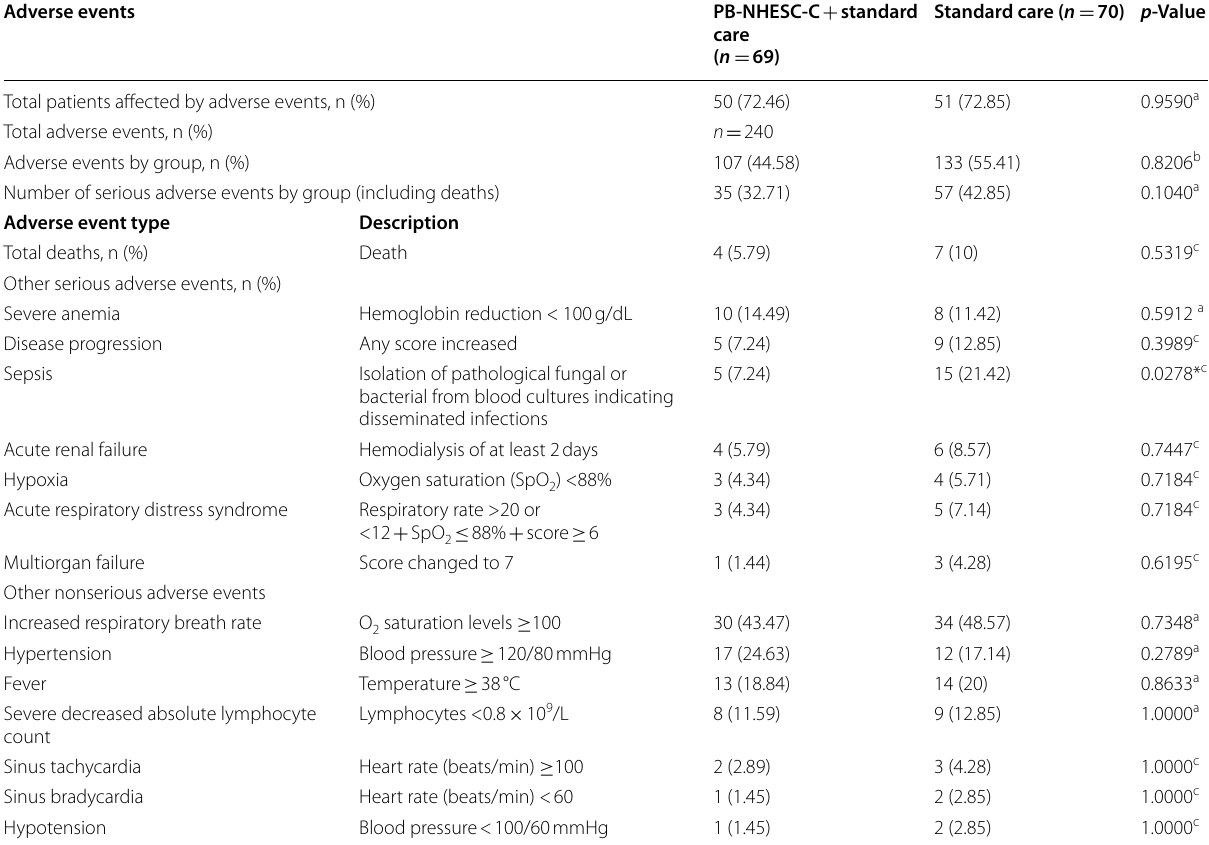
Table 3 Adverse events reported during the follow‑up: SENTAD‑COVID